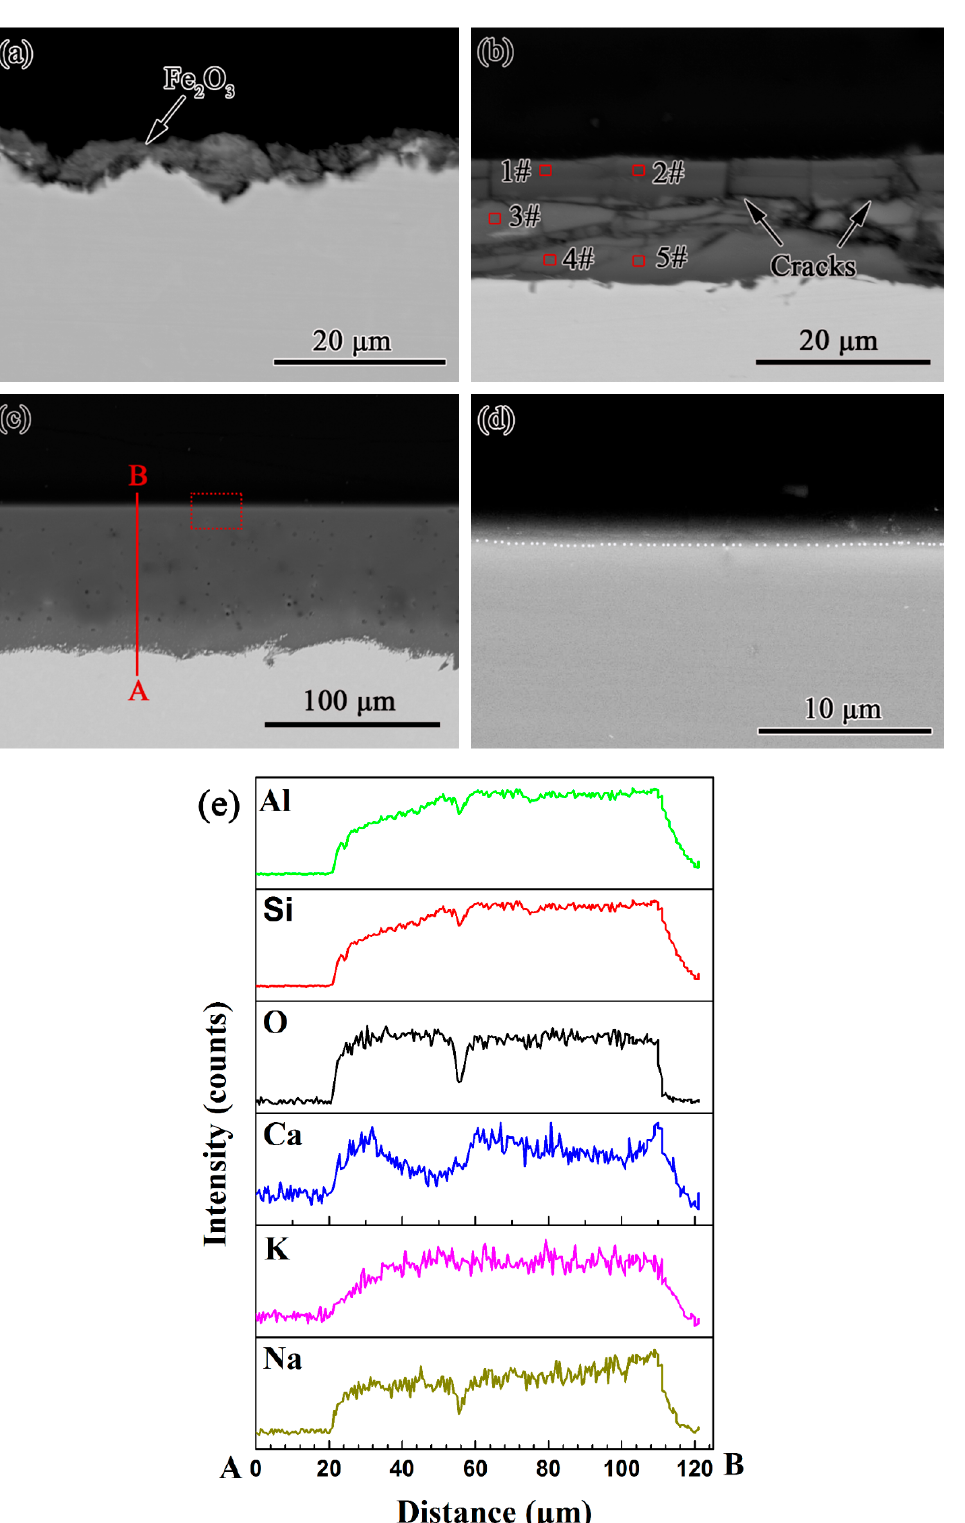
Figure 5. Surface morphologies of the uncoated ( a ), LS ( b ) and HS ( c ) samples after corrosion in the 0.5 M HCl solution at 30 °C for three days.